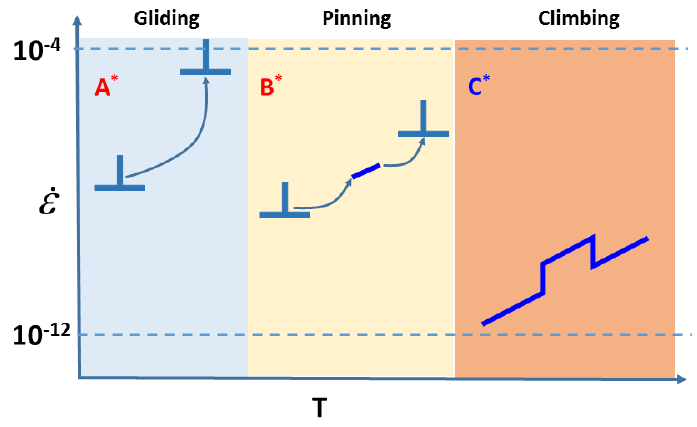
Figure 5. Schematic illustration of the expected behavior of <110> pc dislocations in perovskite materials as a function of temperature, T, and strain rate ε . Thin blue lines represent the dislocation in its glide-dissociated configuration. Adapted from [105].